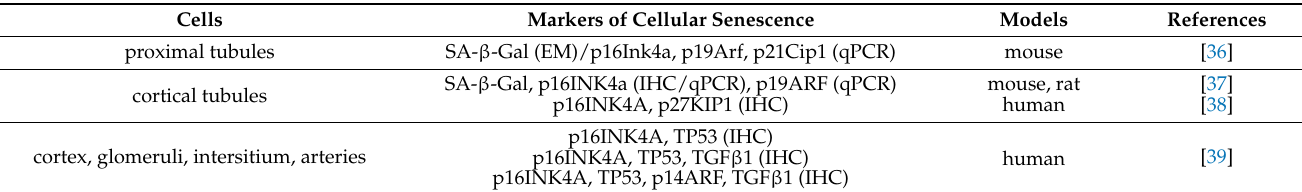
Table 1. Types of cell senescence in kidney